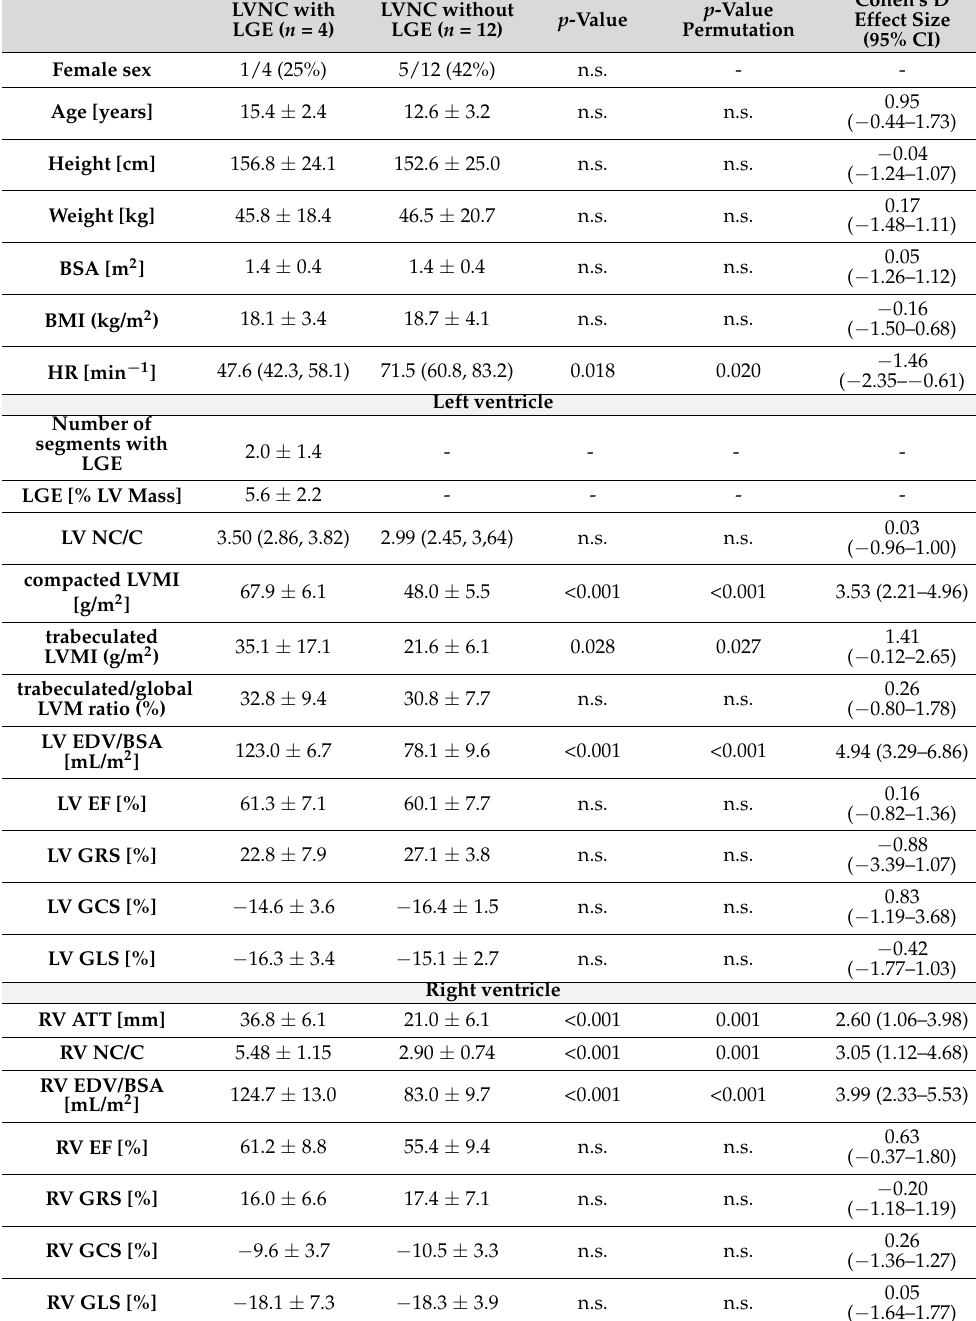
Table 3. Comparison between LVNC patients with and without myocardial late gadolinium enhance- ment (LGE) indicative of fibrosis. BSA indicates body surface area; BMI, body mass index; HR, heart rate; LGE, late gadolinium enhancement; LV, left ventricle; LVM, left ventricular mass; LVMI, left ventricular mass index; EDV, end-diastolic volume; EF, ejection fraction; GRS, global radial strain; GCS, global circumferential strain; GLS, global longitudinal strain; RV, right ventricle; ATT, apical trabeculation thickness; NC/C, noncompacted to compacted ratio. Cohen’s D LVNC with LVNC without p -Value p -Value Effect Size LGE ( n = 4) LGE ( n = 12) Permutation Female sex 1/4 (25%)